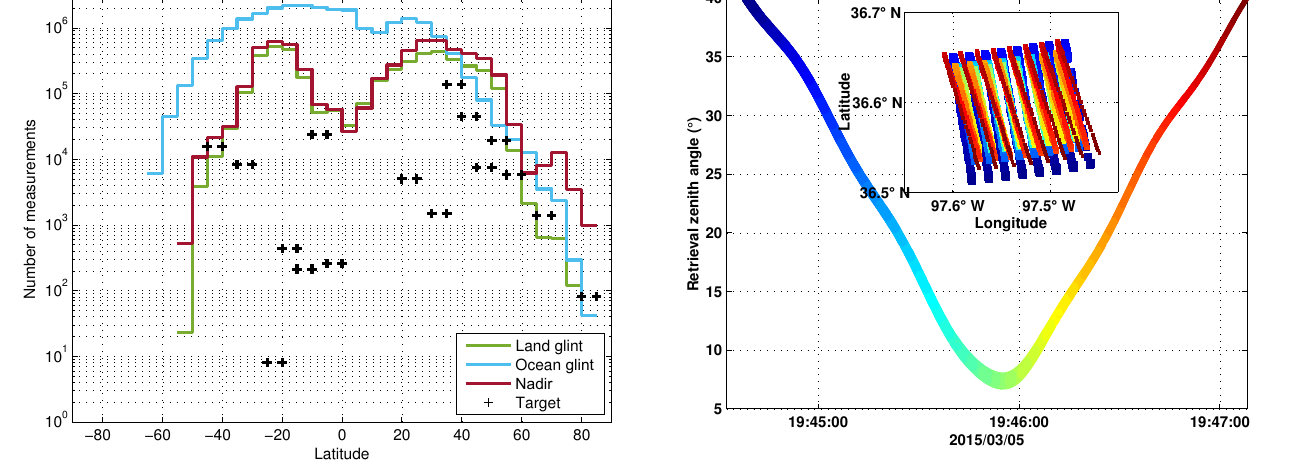
Figure 1. OCO-2 nadir, glint, and target-mode measurement density in 5 ◦ bins as a function of latitude from the beginning of the mission through 31 December 2016. These are from the “lite” files applying “warn level” 11 filters and requiring that the “xco2_quality_flag” is zero.